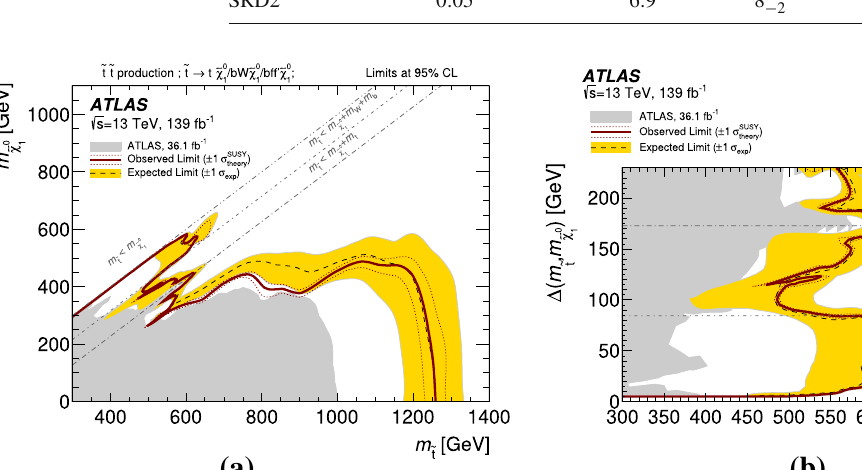
expected limit (yellow band) and the sensitivity of the observed limit to ± 1 σ variations of the signal total cross section (red dotted lines) are also indicated. Observed limits from previous ATLAS searches [22– 25,27,28] based on 36.1 fb − 1 of pp collision data are provided for comparison in